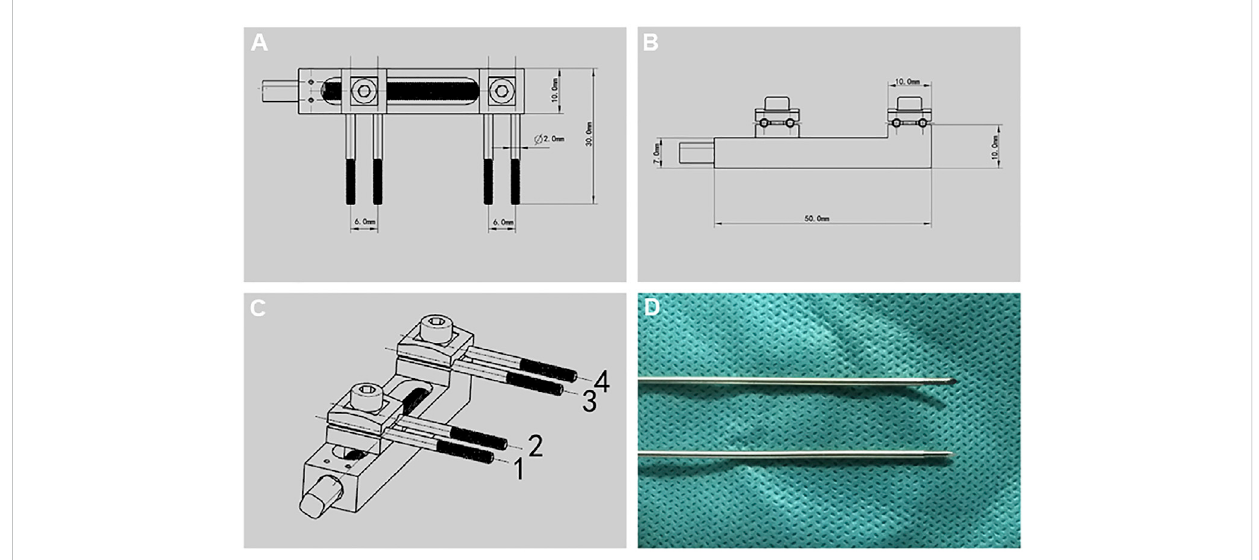
FIGURE 1 Designdrawingofexternal fi xationdeviceandKirschnerwire. (A-C) Designdrawingofexternal fi xationdevice. (D) ThreadedKirschnerwirematched with external fi xation